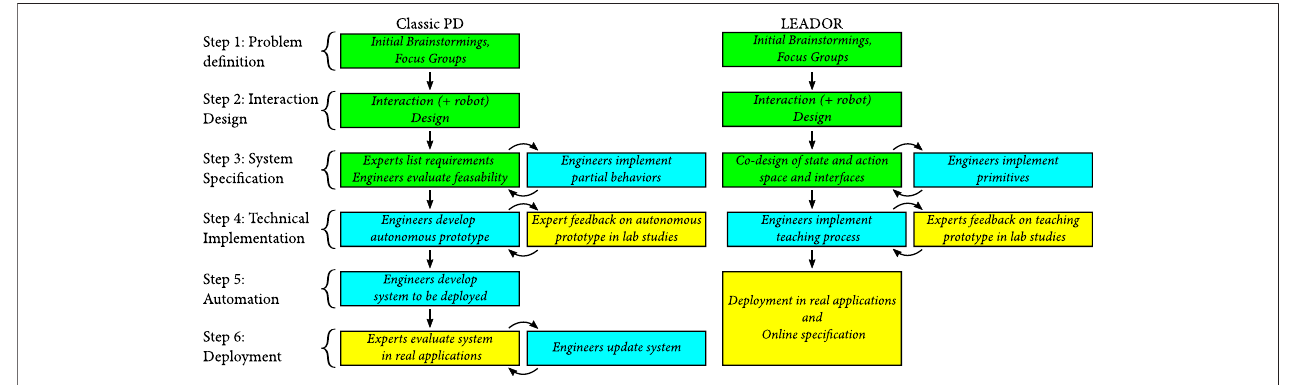
FIGURE 1 | Comparison between a classic participatory design (PD) approach and LEADOR, our proposed end-to-end participatory design approach. Green activities represent joint work between domain experts, multidisciplinary researchers, and/or engineers; yellow activities are domain expert-led; blue activities are engineer-led.ComparedtotypicalPD,thetwokeydifferencesinourapproacharethefocusondevelopinga teachingsystem insteadofa fi nalautonomousbehaviour in step 4, and the combining of autonomous action policy de fi nition and deployment in the real world into a single step 5 + 6. In addition, our method reduces the amount of work that is carried out independently by engineers (i.e., with no domain expert or non-roboticist input).